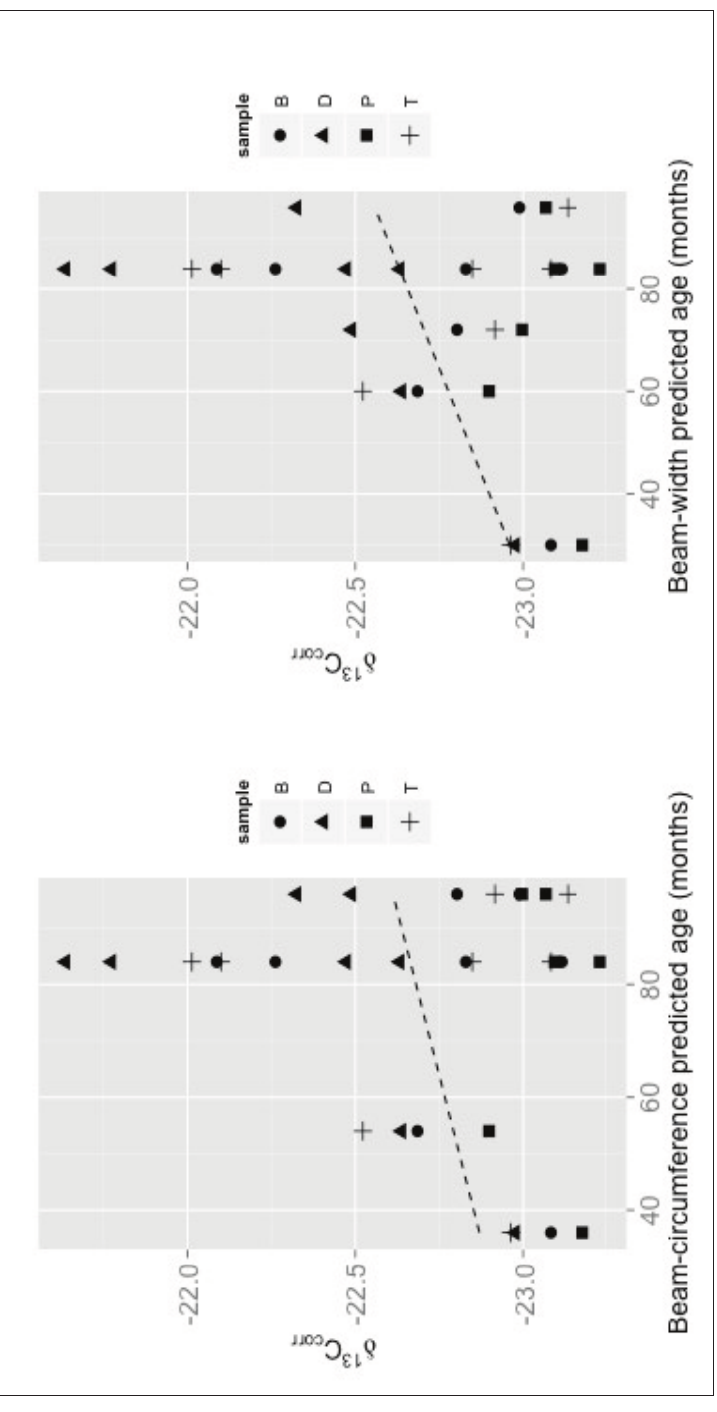
Figure 6a: Variation of δ 13 C and N with predicted age from Billson